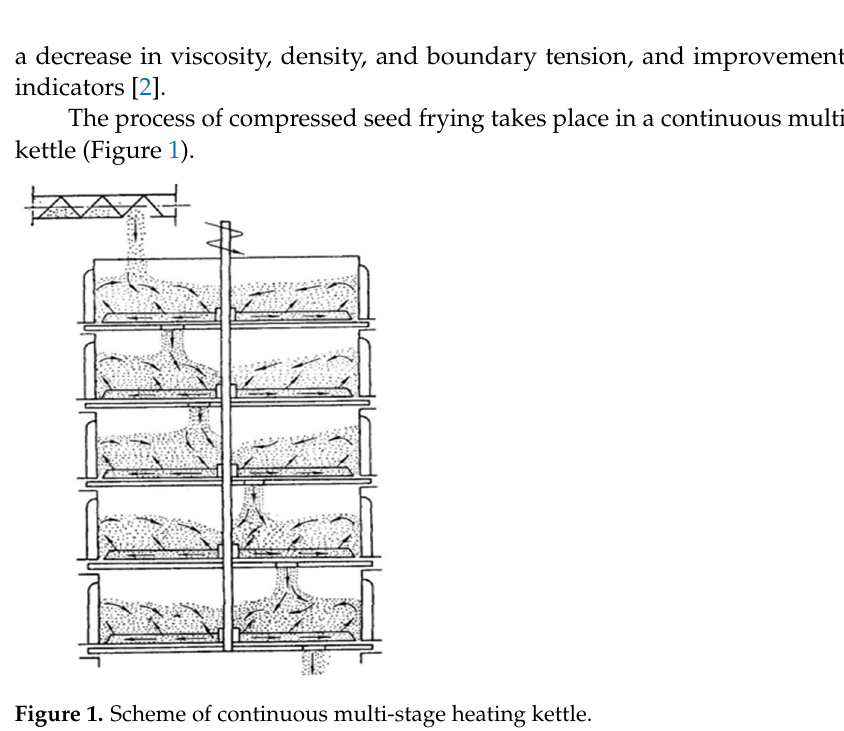
blades at the heating bottoms. High-pressure saturated vapor is supplied to the bottom of the vats to the internal cavities. The temperature of the vats’ side walls under the regular equal to the temperature of the bottom. Compressed seed is fed into the first vat, where the bottom and side surfaces are heated and wet saturated vapor is supplied to the upper surface of the layer. Then, humid raw material is fed into the second and following vats, seed in each vat is the same. Turbine mixers rotate and continuously transfer particles radial and vertical direction [3], which increases the thickness of the dispersed wet layer. The frequency of turbine mixers’ rotation determines the contact time of the com- pressed seed with the heated surfaces of the vat bottom.